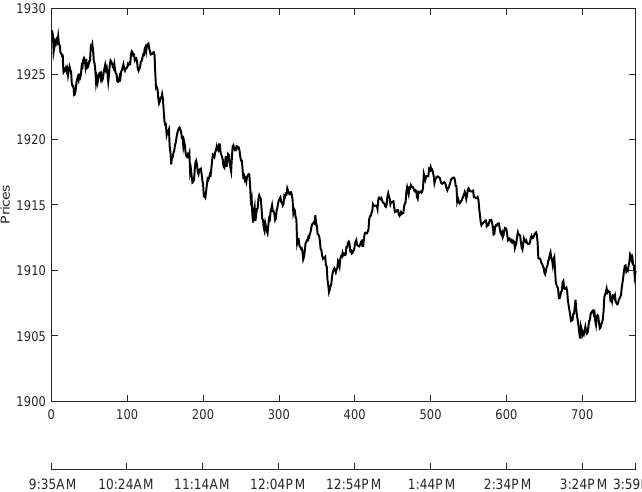
Figure 1. Values of the S&P 500 index for the trading day, 7 August 2014. The first 5 min of the trading day are not